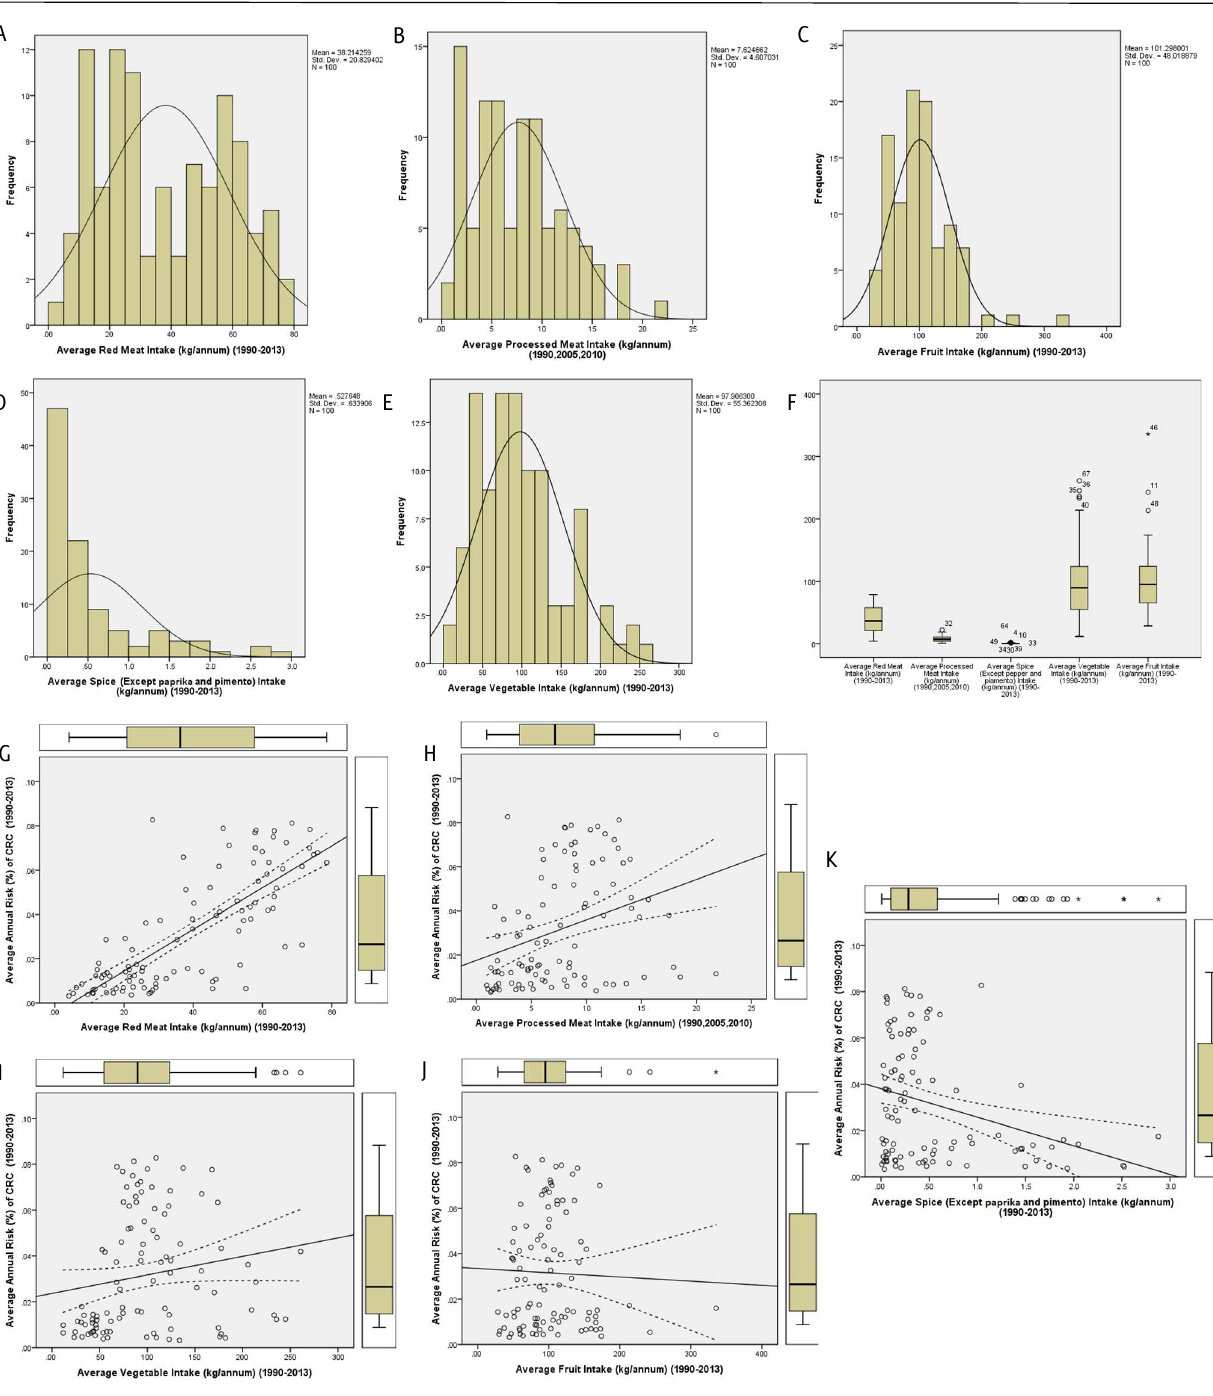
Figure 4 . Statistical Analysis of Data Sets. A-E. Histogram showing the normal distribution and the skewness of the data. F. Boxplots to compare between different dietary intake factors. G-K. Dot plot distribution, visualization of correlation analysis with 95%CI along with the corresponding